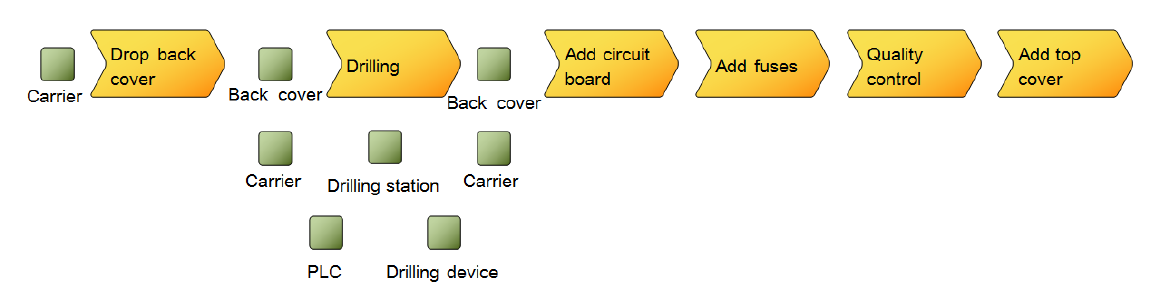
Figure 7. Functional